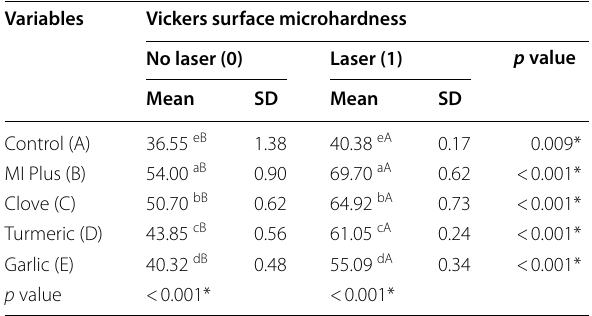
Means with different small letters in the same column indicate significant difference, means with different capital letters in the same row indicate significant difference *; significant ( p < 0.05)